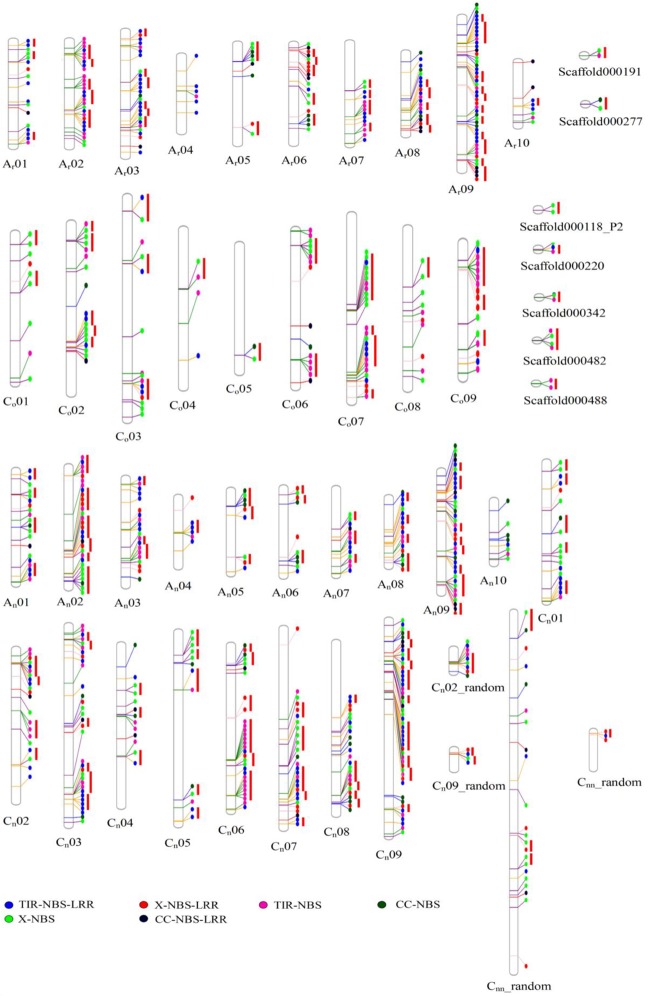
The physical location of NBS-encoding genes in Ar genome of B. rapa, Co genome of B. oleracea and An- and Cn- subgenomes of B. napus. The circles in different colors represented types of NBS-encoding genes.